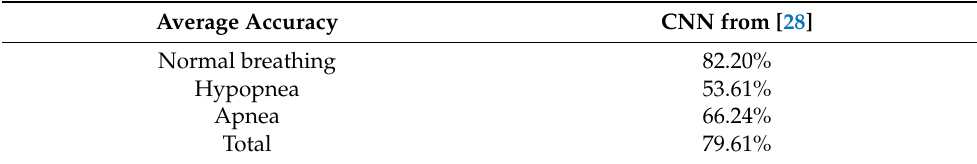
Table 8. Three-class inference accuracy of the CNN from